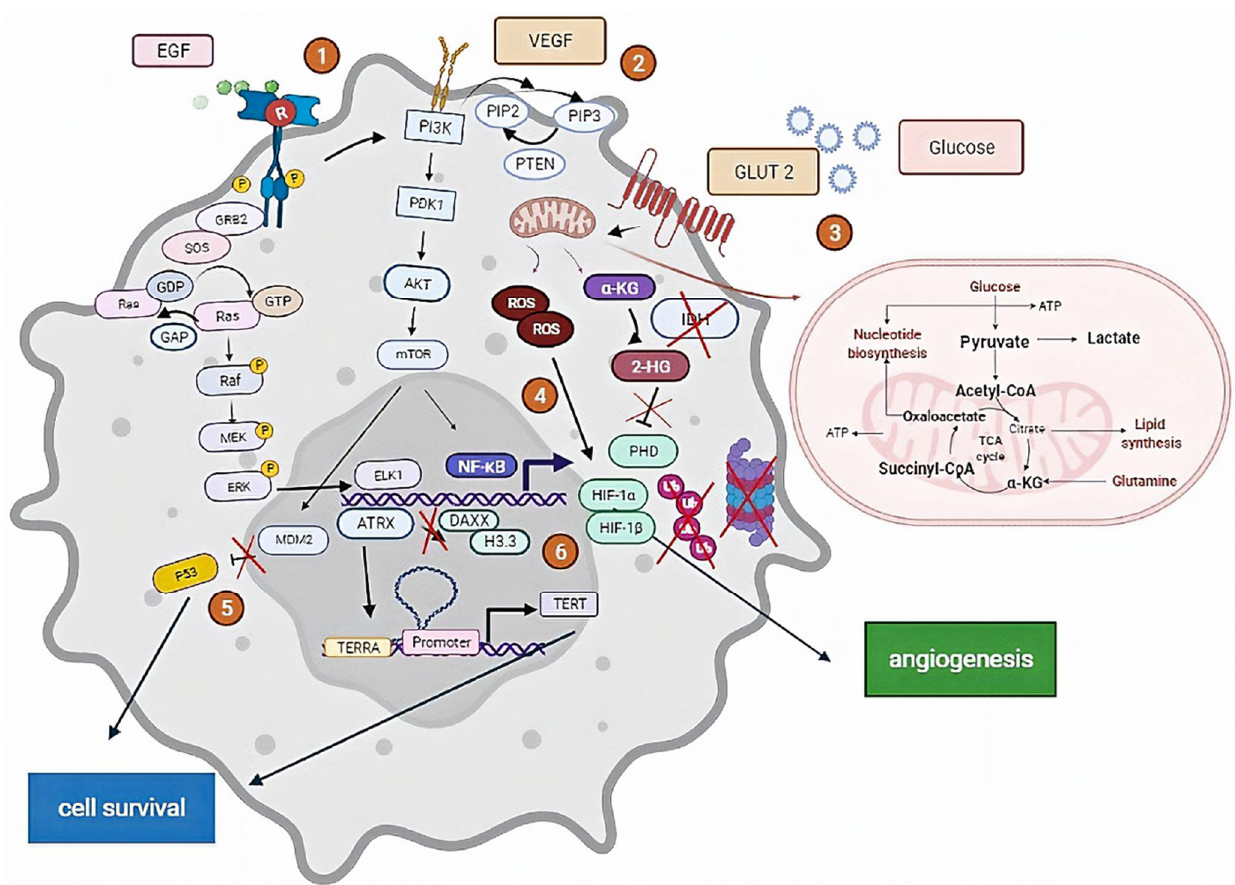
Figure 1. The main signaling pathways investigated in glioblastomas tumorigenesis.